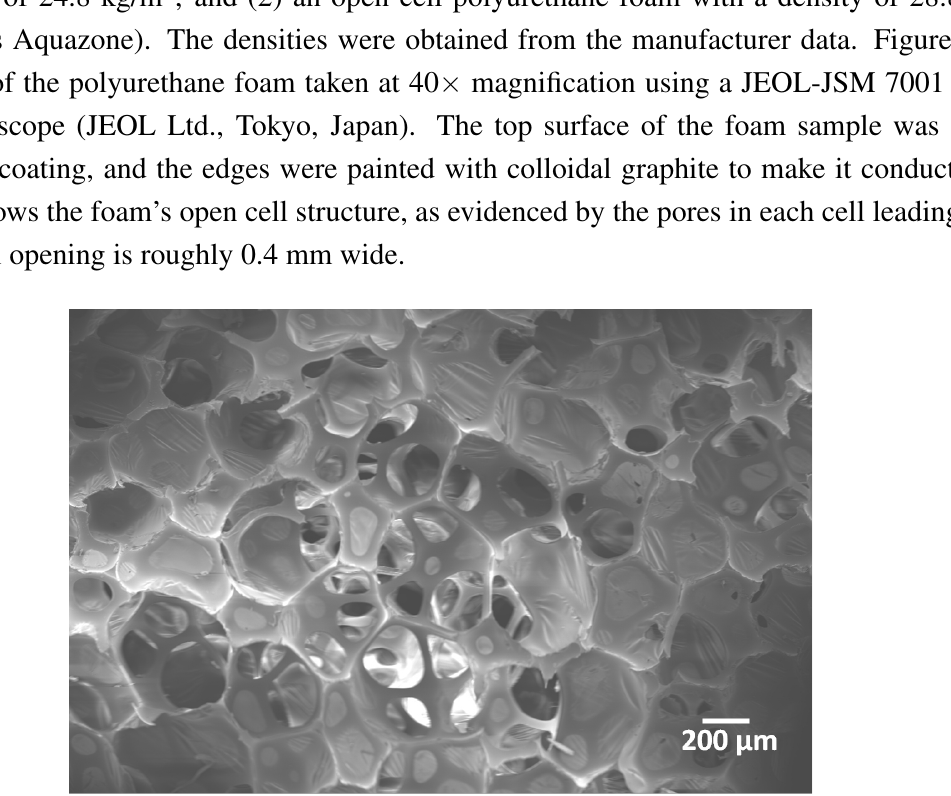
Figure 7. Scanning electron microscope image of the open-celled structure of polyurethane